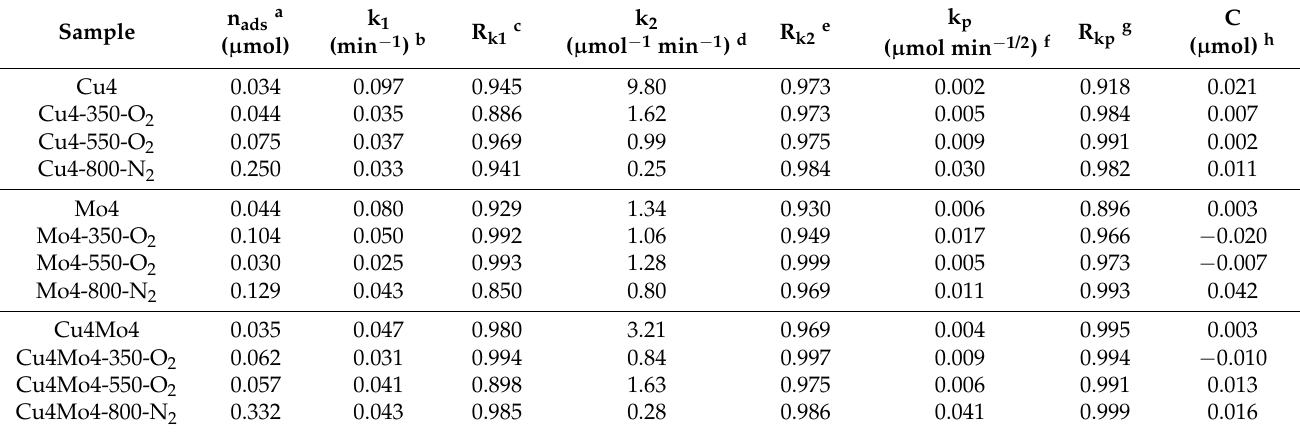
Figure 6. Kinetics of Y5 adsorption in the dark on the series of prepared photocatalysts: ( a ) Cu-based samples; ( b ) Mo-based samples; ( c ) CuMo samples. Table 4. Summary of kinetic parameters of adsorption in the dark of Y5.